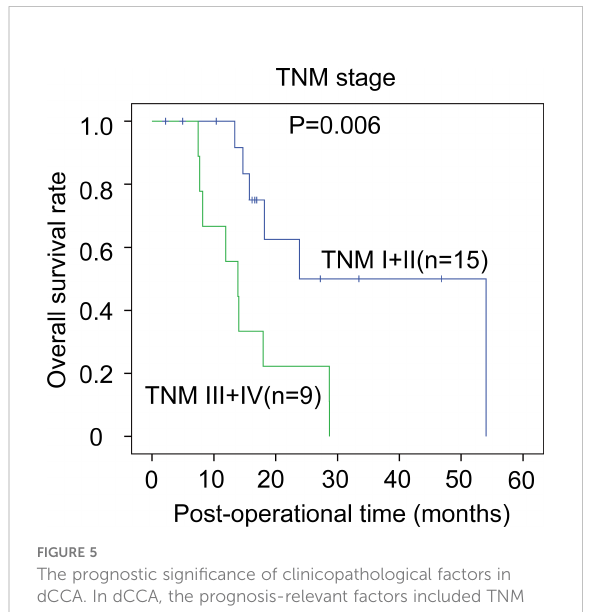
FIGURE 5 The prognostic signi fi cance of clinicopathological factors in dCCA. In dCCA, the prognosis-relevant factors included TNM stage. The statistical signi fi cance between subgroups was analyzed with the log-rank